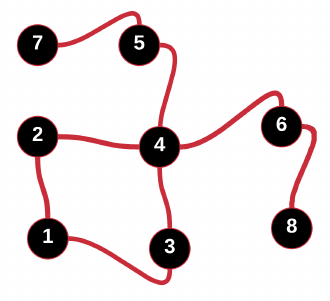
Figure 2. Example of Social